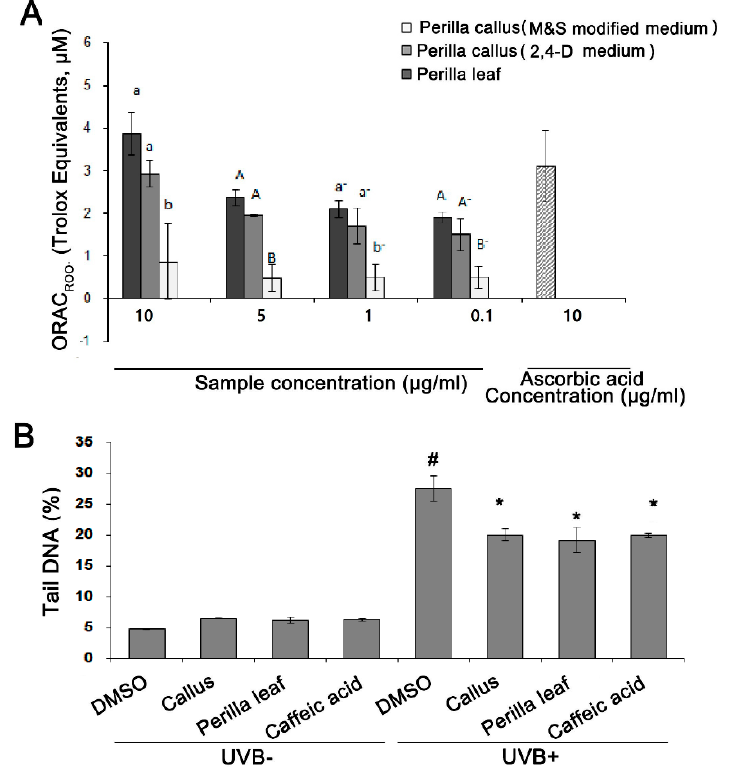
Figure 3. Perilla leaf and callus extracts exhibited antioxidant effects and enhanced DNA repair as determined by the Comet assay in UVB exposed HaCaT cells. ( A ) Antioxidant activities of Perilla leaf and callus extracts as determined by the oxygen radical absorbance capacity (ORAC) ROO · assay in HaCaT cells. The results presented are the means ± SDs of triplicate determinations. Data shown are representative of three independent experiments. Values were compared with those obtained for Perilla callus extracts induced by MS modified medium and 2,4-dichlorophenoxy acetic acid (2,4-D) medium, and leaf extracts at the same concentrations, as 1 uM trolox equivalent. p < 0.01 as determined by Duncan’s test. ( B ) DNA damage was assessed using the Comet assay. Tail DNA percentages were determined. Comet images revealed different degrees of DNA damage. HaCaT cells were cultured in 6-well plates and pretreated with Perilla leaf or callus extracts (at 0.1 μ g/mL), caffeic acid (150 μ M; the positive control), or DMSO (the negative control) for 12 h, exposed to UVB (50 mJ/cm 2 ), and then cultured for 12 h later. The bar graph was calculated from three independent experiments. Images of fluorescence intensities were obtained using the Comet assay. # p < 0.05; significant versus UVB non-treated and DMSO controls. * p < 0.05; significant versus UVB treated and DMSO controls. Different letters indicate significant intergroup differences ( p <